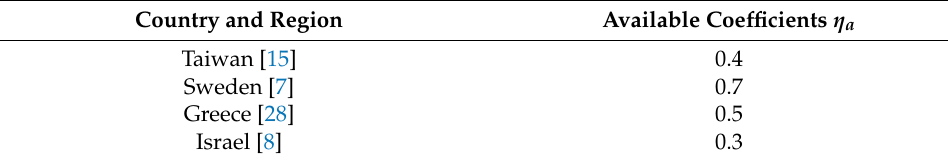
Table 2. Values of available coefficients η a for different documents.